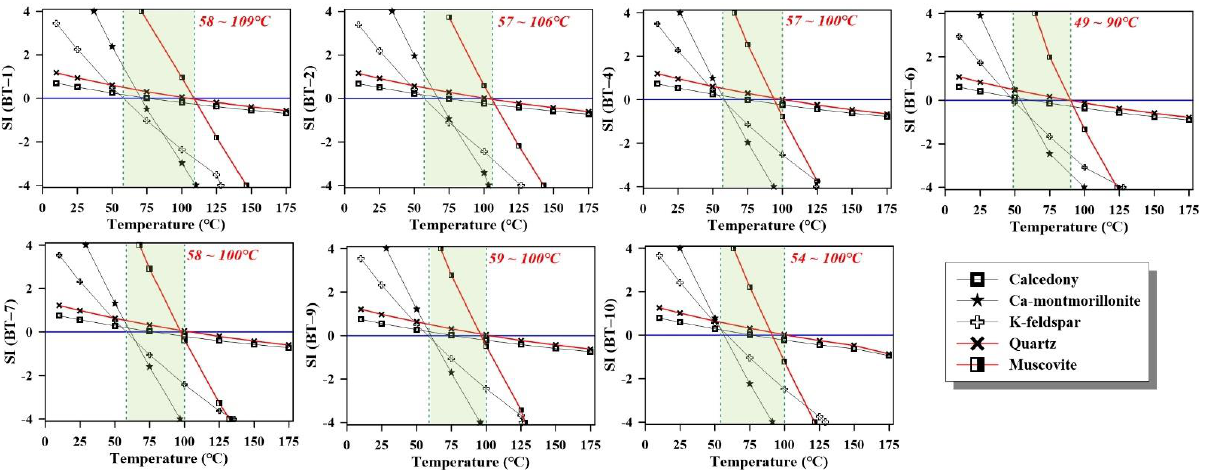
Figure 10. Multicomponent geothermometry using saturation indices of several minerals concerning the chemical composition of thermal waters. Table 4. Estimated reservoir temperature of Bugok thermal waters.